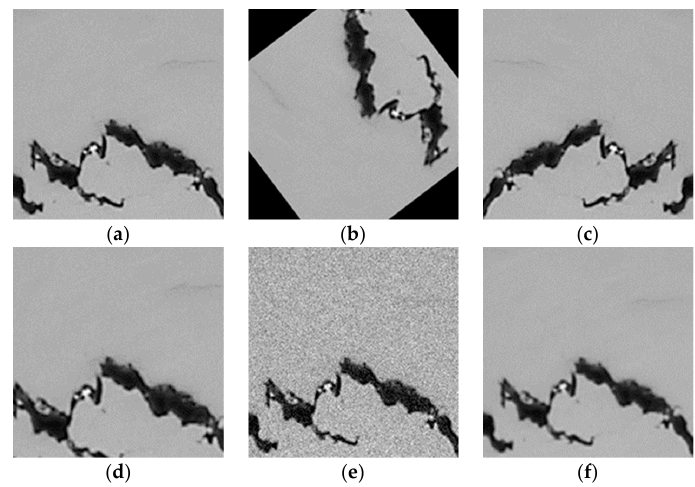
Figure 2. Data augmentation: ( a ) origin image, ( b ) rotation, ( c ) flipping, ( d ) crop, ( e ) adding Gaussian noise, and ( f ) adding blur.